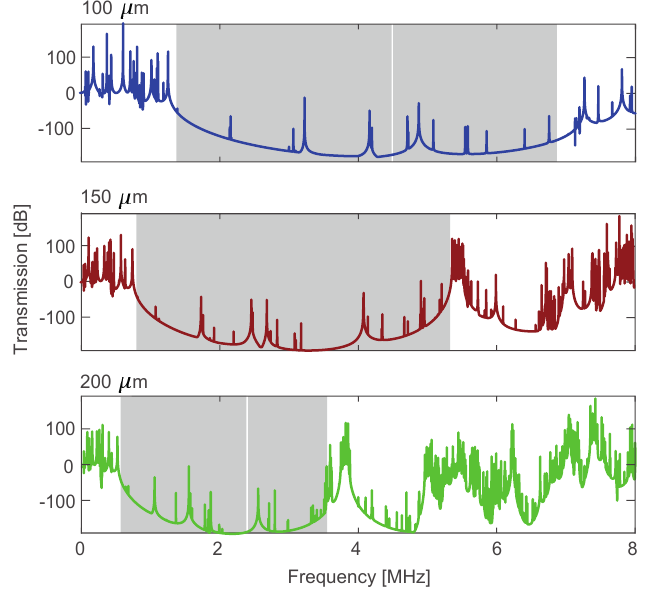
Figure 6. Transmission diagrams numerically computed for the three fabricated metastructures. Bandgaps estimated through dispersion analyses are reported as shaded grey